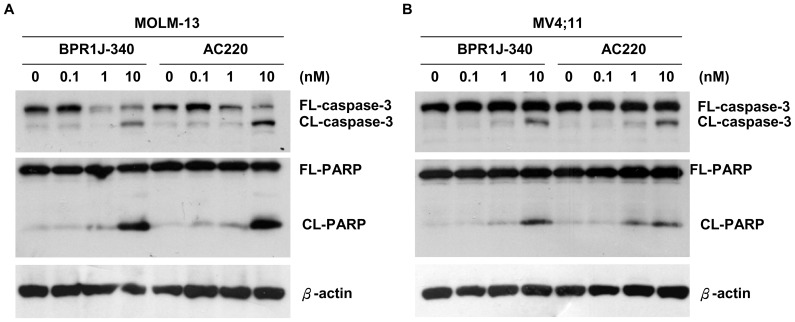
BPR1J-340 induces apoptosis in MOLM-13 and MV4;11 cells.Western blotting revealed that BPR1J-340 was able to induce apoptosis in FLT3-ITD-driven FLT3-ITD+ AML cells. MOLM-13 (A) and MV4;11 (B) cells were treated with BPR1J-340 at the indicated concentrations for 24 hours, and the cell lysates were then subjected to Western blot analysis using antibodies against caspase-3 and PARP (poly-ADP-ribose polymerase). (full length caspase-3 (FL-caspase-3), cleavage of caspase-3 (CL-caspase-3), full length poly(ADP-ribose) polymerase (FL-PARP), cleavage of PARP (CL-PARP)).